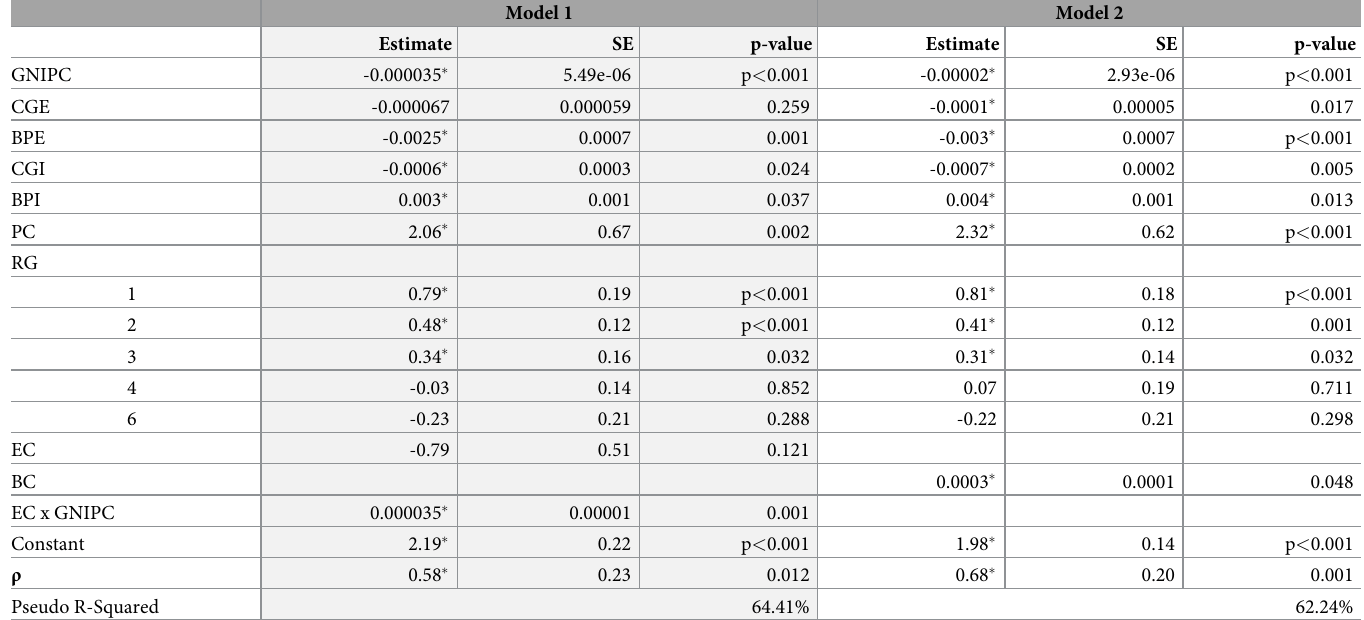
Table 5. The effect of trade, purchasing power, land, and wheat imports on